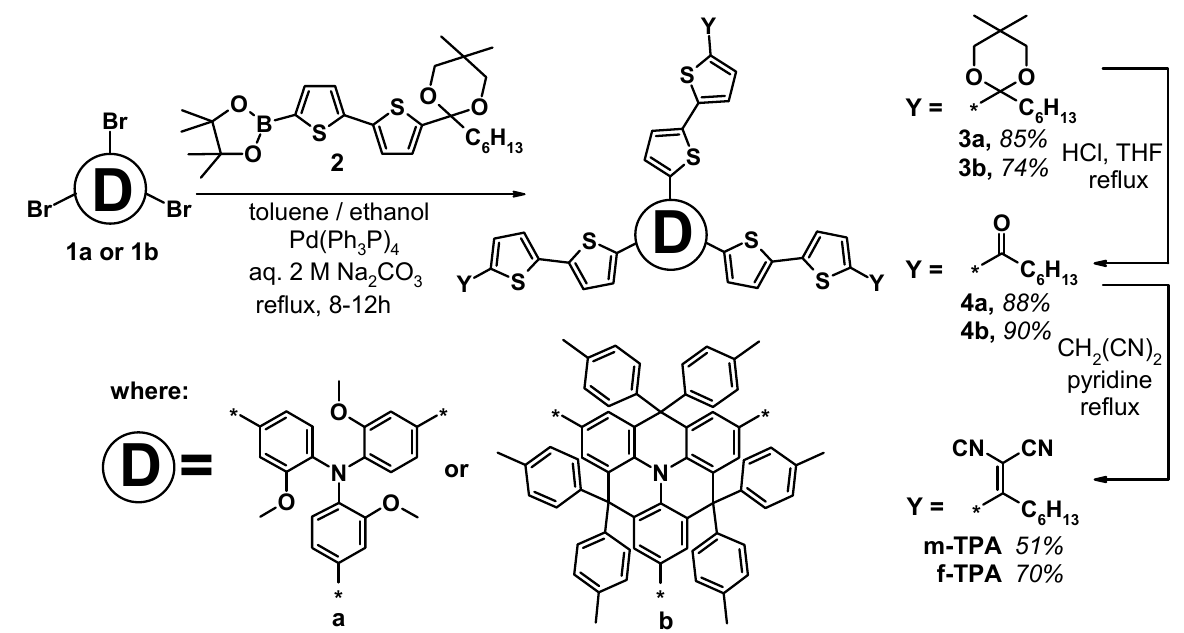
Figure 2. Scheme synthesis of m-TPA and f-TPA molecules.